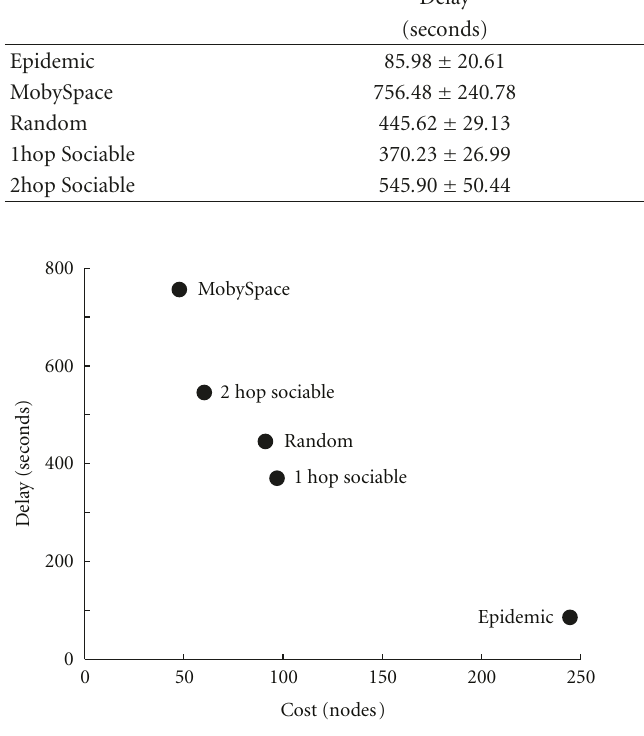
Figure 6: Position of the examined routing schemes on the delay versus cost